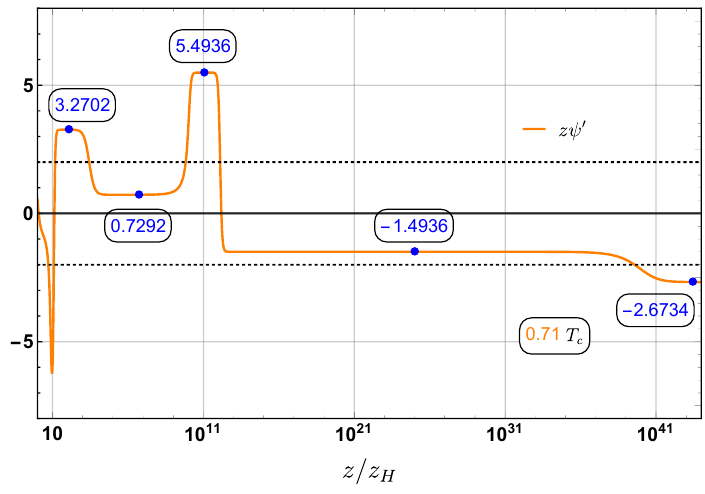
Figure 10 . Check the validity of the transformation rule for alternation of Kasner epochs. We choose T = 0 . 71 T for which two Kanser transitions and two Kasner inversions are shown. The c value of α = zψ 0 for each Kanser epoch is labeled explicitly. Two horizontal dashed lines correspond to | α | = 2 . The transformation rule (3.22) is confirmed quantitatively.